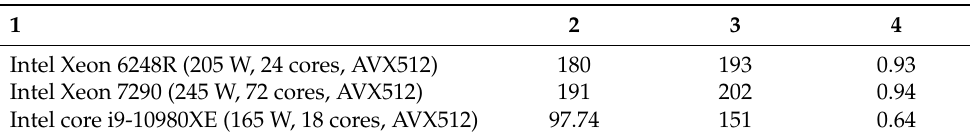
Table 1. Energy efficiency of PIC code for numerical simulation of plasma dynamics problem in open trap. 1-CPU type, 2-Performance (GFLOPS), 3-Power Consumption (Watts), 4-Energy Efficiency